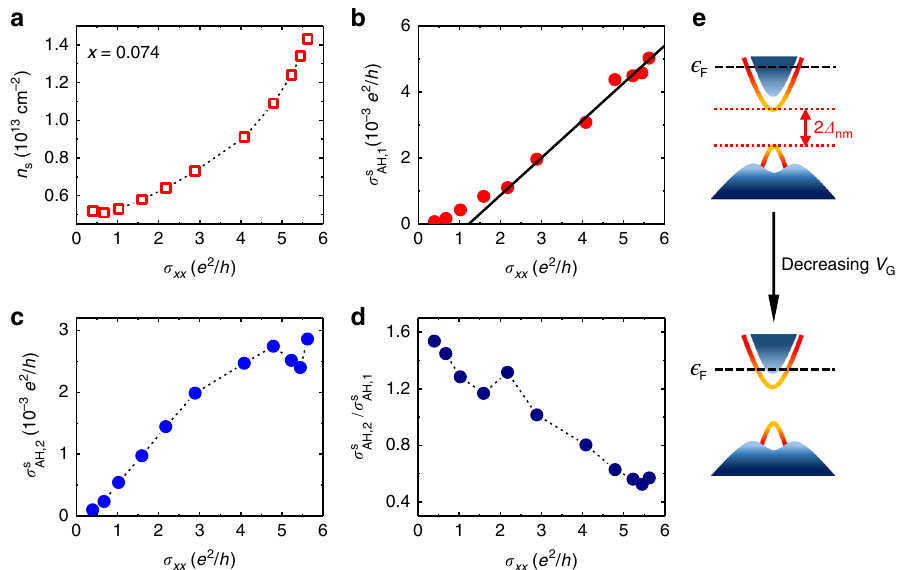
Fig. 6 Characteristics of the AH conductivity in a heavily doped (Bi 1 -x Mn x ) 2 Se 3 sample ( x = 0.074). Plotted in panels a – d are σ xx dependences of n s , σ AH ; 1 , σ σ s = σ s , respectively. e Schematic band diagrams of the (Bi,Mn) 2 Se 3 sample with high and low Fermi levels. The data shown in AH ; 2 , and the ratio AH ; 1 AH ; 2 panels a – d were extracted from the Hall effect data taken from Sample F at T = 1.6